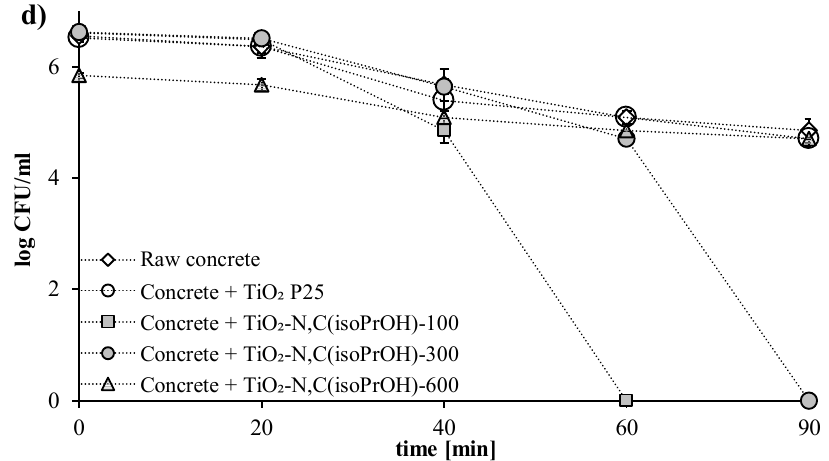
Figure 3. Inactivation rate of E. coli bacteria on the raw concrete plates, plates implemented commercial TiO 2 P25 and ( a ) TiO 2 / N photocatalysts, ( b ) TiO 2 / N,C MeOH , ( c ) TiO 2 / N,C EtOH and ( d ) TiO 2 / N,C iso-PrOH under artificial solar light irradiation. Table 3. The reduction [%] of initial bacteria cells number under artificial solar light.